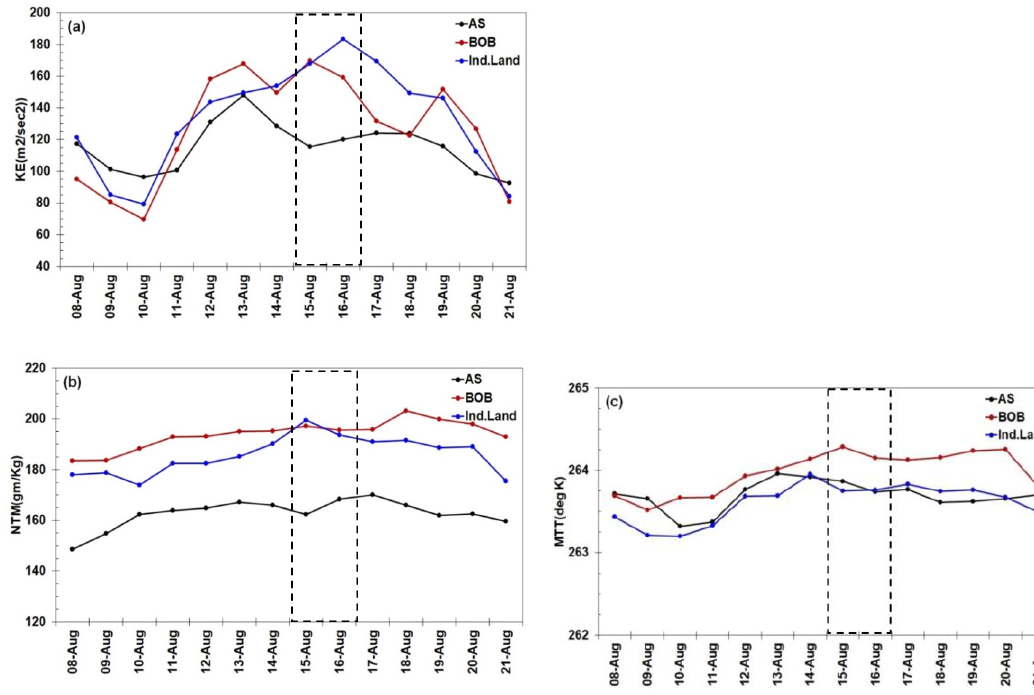
5 ◦ N–15 ◦ N; in black), Bay of Bengal (BoB) (82.5 ◦ E–97.5 ◦ E; 5 ◦ N–15 ◦ N; in red), and Indian landmass Figure 4. ( a ) 850 hPa daily variation of kinetic energy (m 2 s −2 ) over the Arabian Sea (50° E –72.5° E; 5 ° (72.5 ◦ E–82.5 ◦ E; 5 ◦ N–15 ◦ N; in blue) were derived from ERA-Interim reanalysis for 00 UTC of N –15° N; in black), Bay of Bengal (BoB) (82.5° E –97.5° E; 5° N –15° N; in red), and Indian landmass 8–21 August 2018, as were ( b ) the net tropospheric moisture (NTM; gm kg − 1 ) and ( c ) mean tropospheric (72.5° E –82.5° E; 5° N –15° N; in blue) were derived from ERA-Interim reanalysis for 00 UTC of 08– temperature (MTT; ◦ 21 August 2018, as were ( b ) the net tropospheric moisture (NTM; gm Kg −1 ) and ( c ) mean tropospheric temperature (MTT; °K).